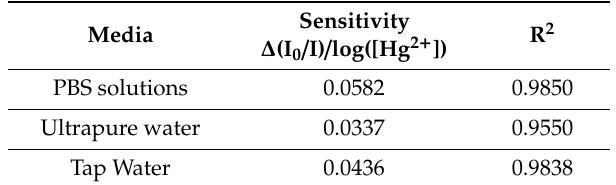
Table 1. Sensitivities measured for the di ff erent aqueous solutions.